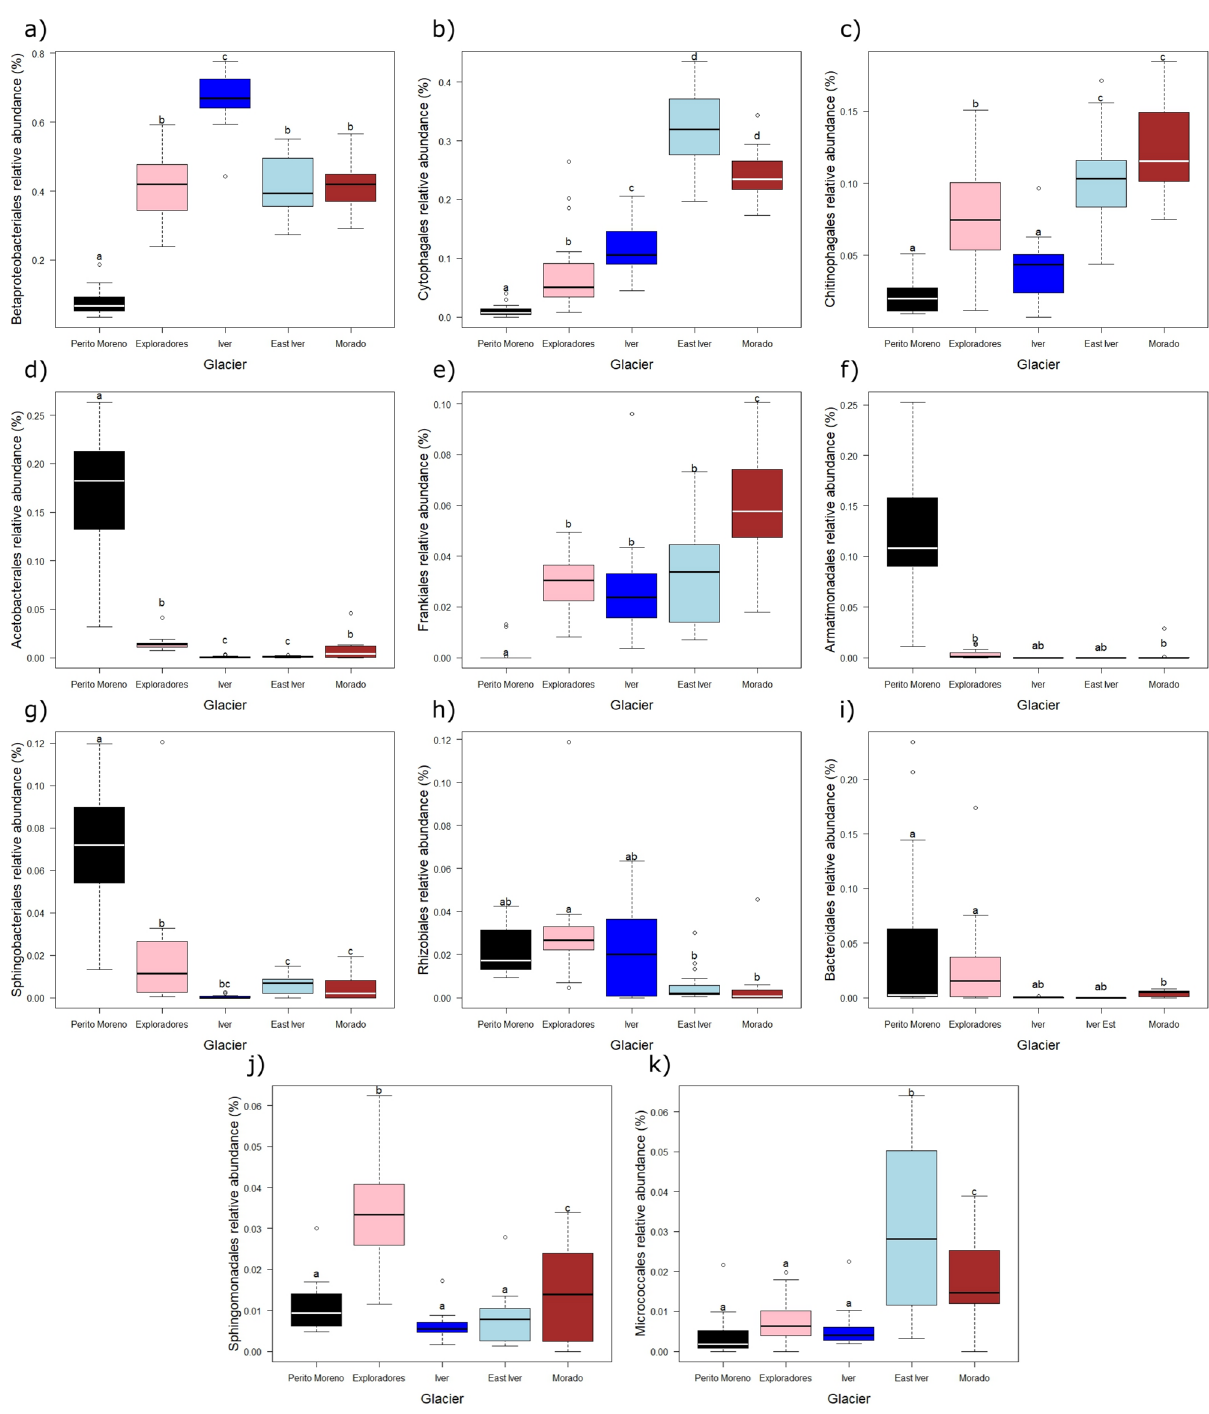
Figure 5. Boxplots of the relative abundances of Betaproteobacteriales ( a ), Cytophagales ( b ), Chitinophagales ( c ), Acetobacterales ( d ), Frankiales ( e ), Armatimonadales ( f ), Sphingobacteriales ( g ), Rhizobiales ( h ), Bacteroidales( i ), Sphingomonadales ( j ) and Micrococcales ( k ) on the five glaciers where we collected cryoconite samples. The thick lines represent the median, boxes upper and lower limits the 25th and the 75th percentiles respectively, whiskers the 5th and the 95th percentiles respectively, dots represent the outliers and different letters indicate differences between the mean values of different